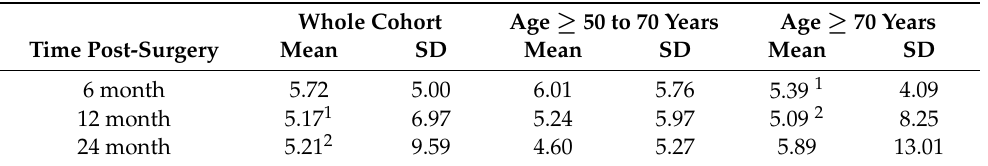
Table 3. Distribution of speech perception in noise in patients groups. The mean speech perception threshold (dB S / N ) was measured with OLSA test in 65 dB background noise. SD = standard deviation. “ 1 ” and “ 2 ” indicate significant differences between respective variables compared to their values per Wilcoxon signed-rank test. p ≤ 0.05.